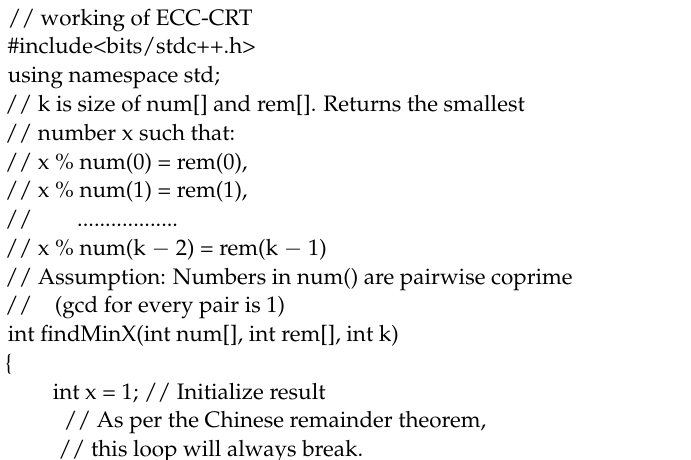
Figure 6. Mesh Chinese remainder